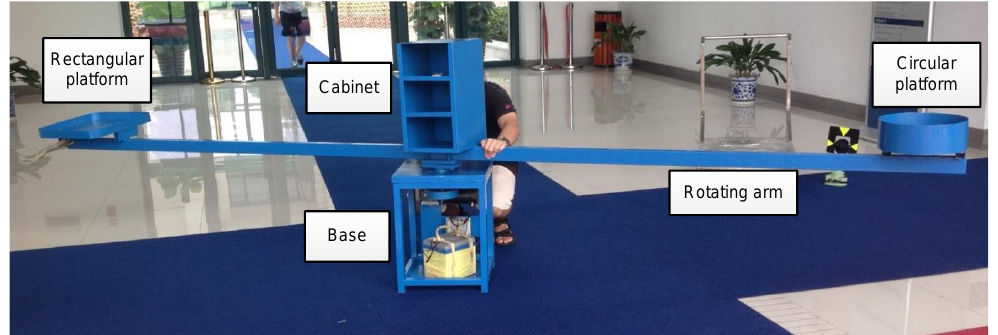
Figure 7. The rotating arm rig for testing of the proposed method with real multipath data. Table 6 . Details of the collection of the real kinematic datasets.